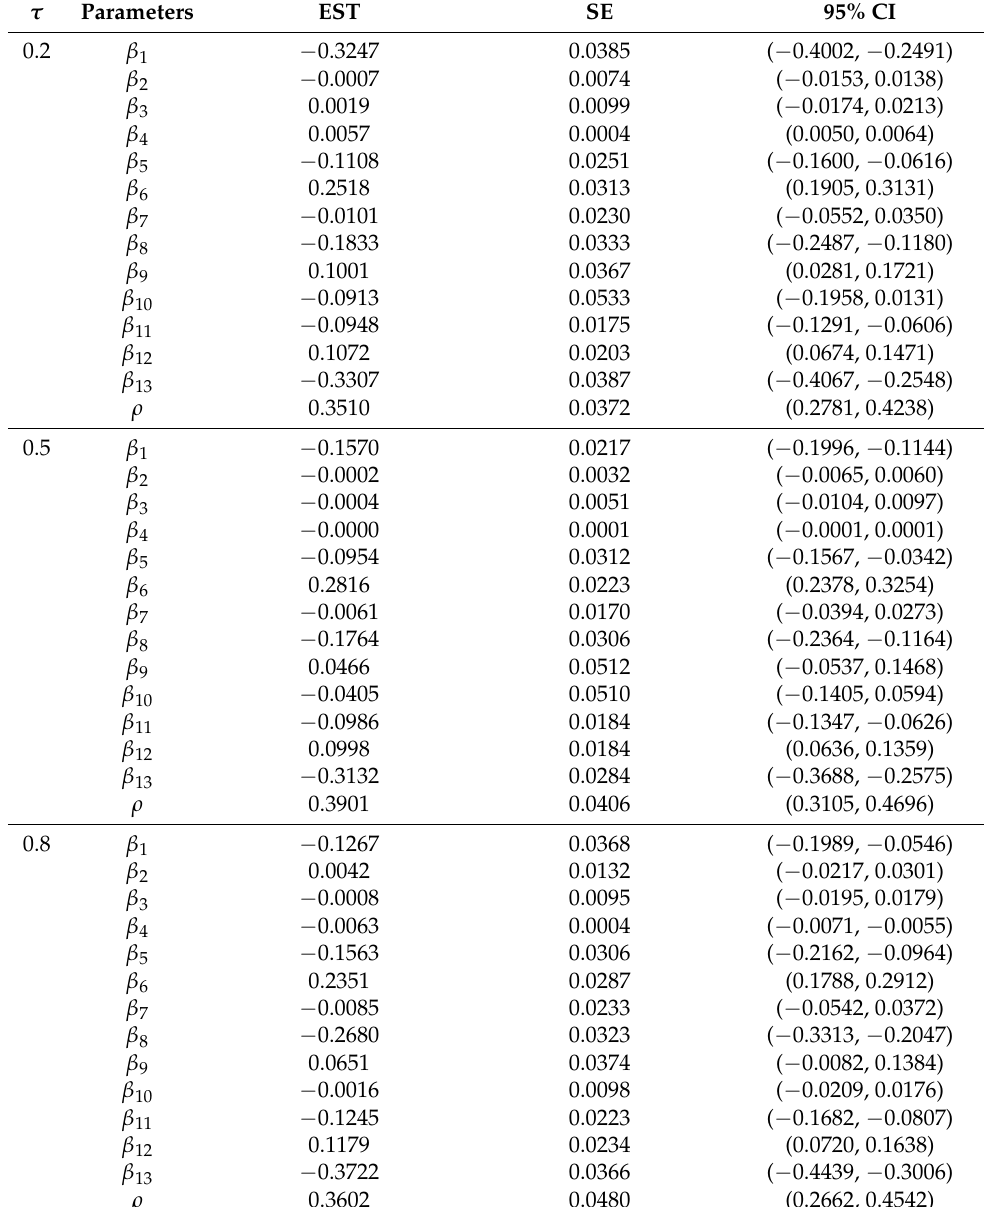
Table 6. Bayesian estimation results based on SAR quantile models in the Boston housing price data